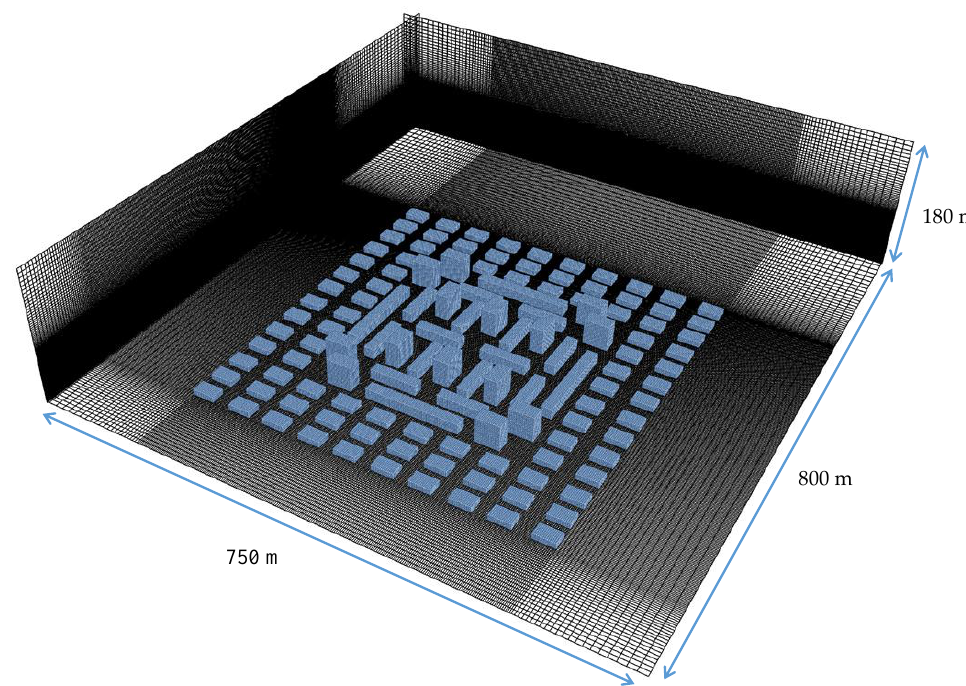
Figure 5. Example of the calculation grid used for CFD simulations (UM-2 case).